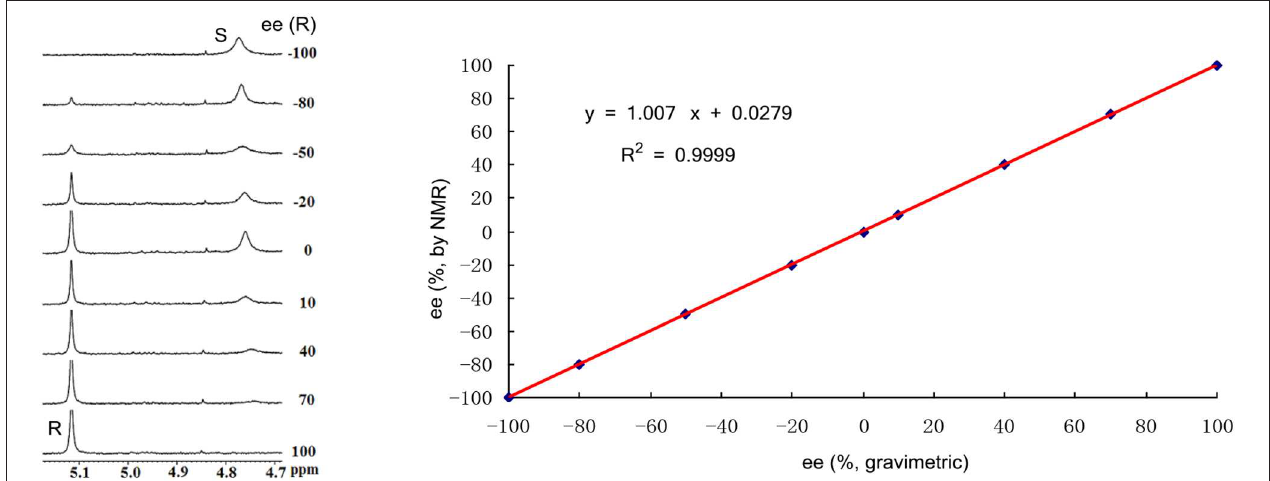
FIGURE 2 | Selected overlaid partial 1 H NMR spectra of nine different optical purities ortho-chloro-MA samples (ee% = R % – S %) in the presence of 2 equiv. BINOL-amino alcohol 3 (left); its linear correlation between the observed ( y ) and theoretical ee% values ( x ) of ortho-chloro-mandelic acid